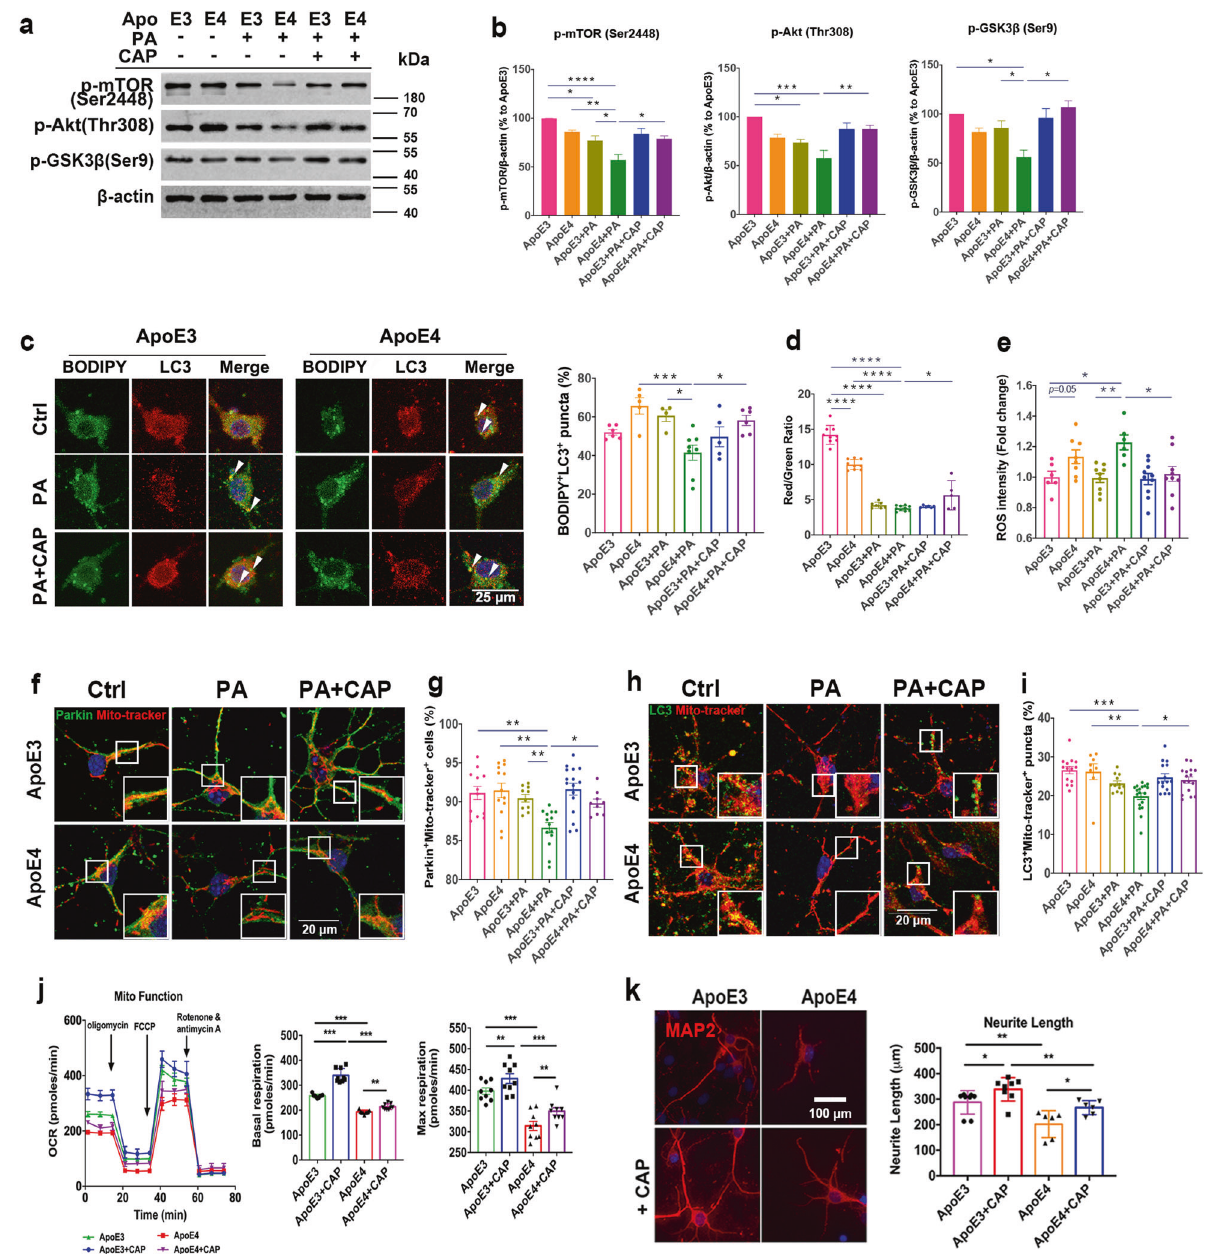
Fig. 3 TRPV1 activation reversed ApoE4-induced neuronal autophagy impairment and lipid droplet accumulation in vitro. a , b Western blot and quanti fi cation of phospho-mTOR (Ser2448), phospho-Akt (Thr308), and phospho-GSK3 β in SH-sy5y cells treated with 150 nM recombinant ApoE and 100 μ M PA for 24 h. c Representative immuno fl uorescent images and quanti fi cation of BODIPY + LC3 + puncta in primary neurons. d Quanti fi cation of cellular MMP in primary neurons stained with JC-1. e Quanti fi cation of cellular ROS production in primary neurons stained with DCFH-DA. f – i Representative immuno fl uorescent images and quanti fi cation of Parkin and MitoTracker Red ( f , g ) or LC3 and MitoTracker Red ( h , i ). j Mitochondrial stress test of 150 nM ApoE3- and ApoE4-treated neurons for 24 h with pretreatment with 10 μ M capsaicin; basal respiration and maximal respiration are shown. k Confocal images of MAP2 + (neurite) cells treated with 150 nM ApoE3 and ApoE4 for 24 h. Quanti fi cation of the mean neurite length of MAP2 + cells from confocal images. Experiments on primary neurons were performed three times in technical triplicates. Statistical tests: one-way ANOVA followed by Tukey ’ s post hoc test ( b – e , g , i , j , k ). Data represent the mean ± s.e.m. * p < 0.05, ** p < 0.01, *** p < 0.001, **** p < 0.0001. Scale bars, 25 μ m ( c ), 20 μ m ( f , h ), 100 μ m ( k TRPV1 activation attenuated the microgliosis phenotype in (Supplementary Fig. 4a, b). Double staining of NeuN and Parkin or ApoE4 HFD mice LC3B revealed that the percentage of Parkin + or LC3 + neurons was As brain-resident immune cells, microglia represent a proin- signi fi cantly increased in the cerebral cortex of ApoE4 HFD + fl ammatory and phagocytosis impairment state with lipid capsaicin mice compared to that in ApoE4 HFD mice (Supplemen- droplet accumulation in the aging mouse brain 29 . Transcrip- tary Fig. 4c, d). Moreover, colocalization of BODIPY + LC3 + puncta was increased in ApoE4 HFD + capsaicin mice compared to that in tome pro fi les of genes related to microglial functions were ApoE4 HFD mice (Supplementary Fig. 4e, f). analyzed. Genes highly expressed in adult homeostasis